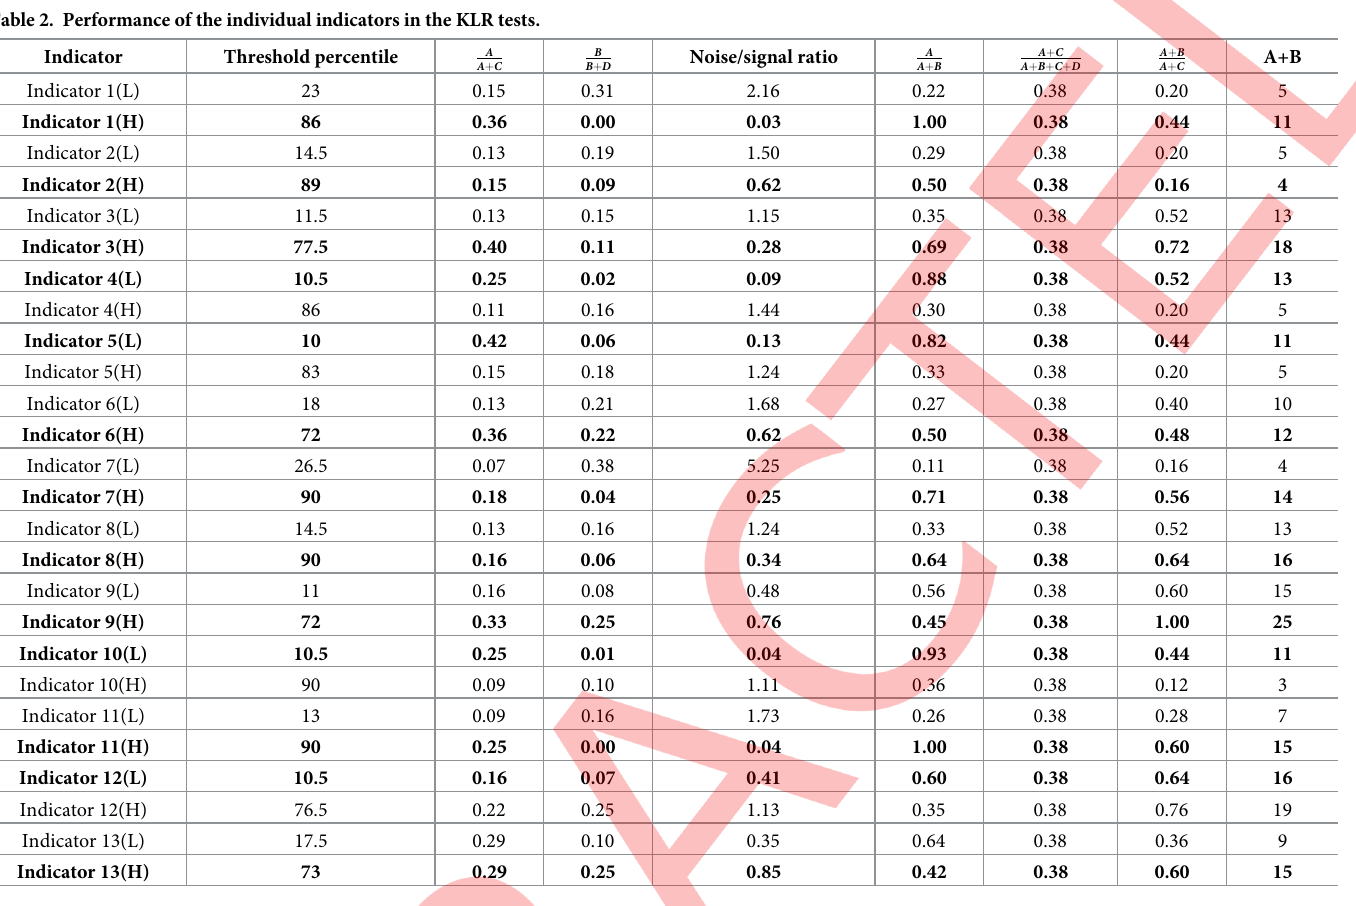
Table 2. Performance of the individual indicators in the KLR tests.